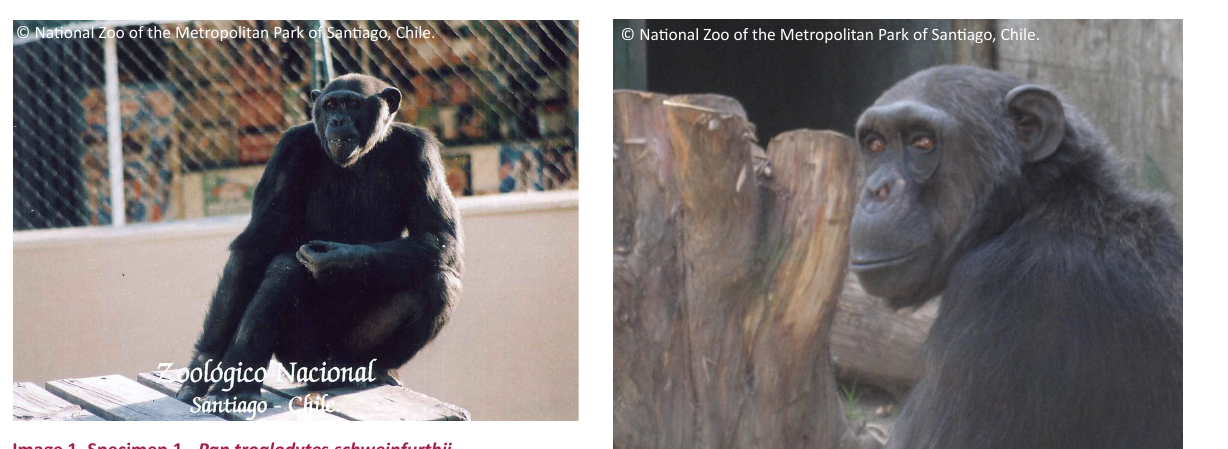
Image 2. Specimen 1 - Pan troglodyte s schweinfurthii